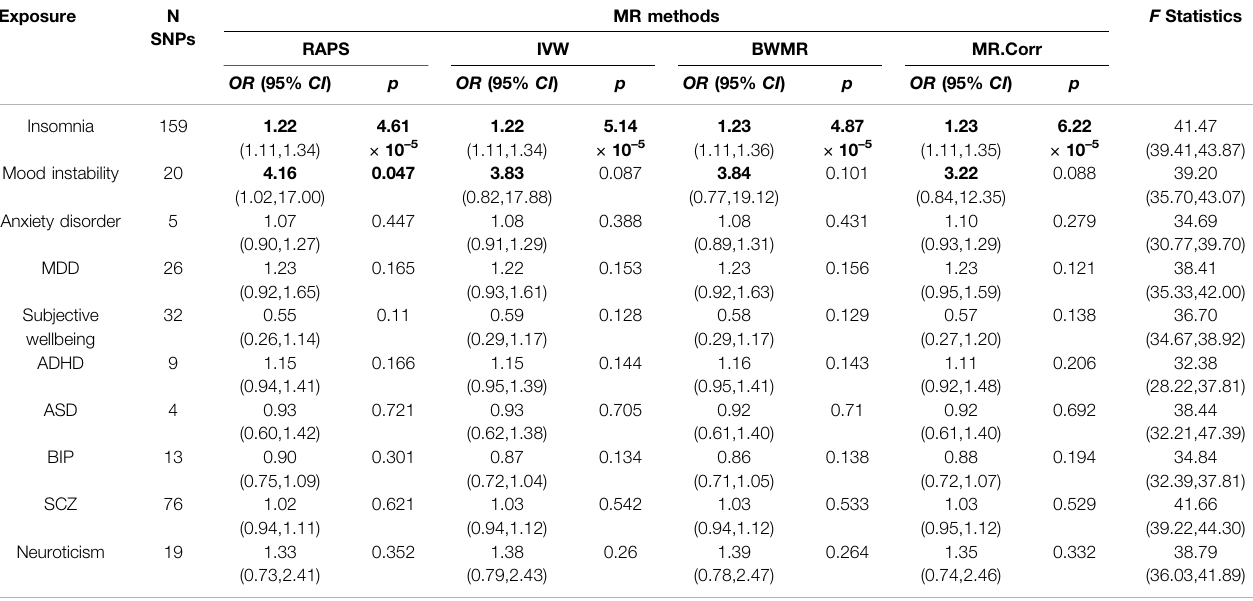
TABLE 2 | The causal effects of the ten psychiatric traits on IAs by two-sample MR analyses. Exposure N SNPs